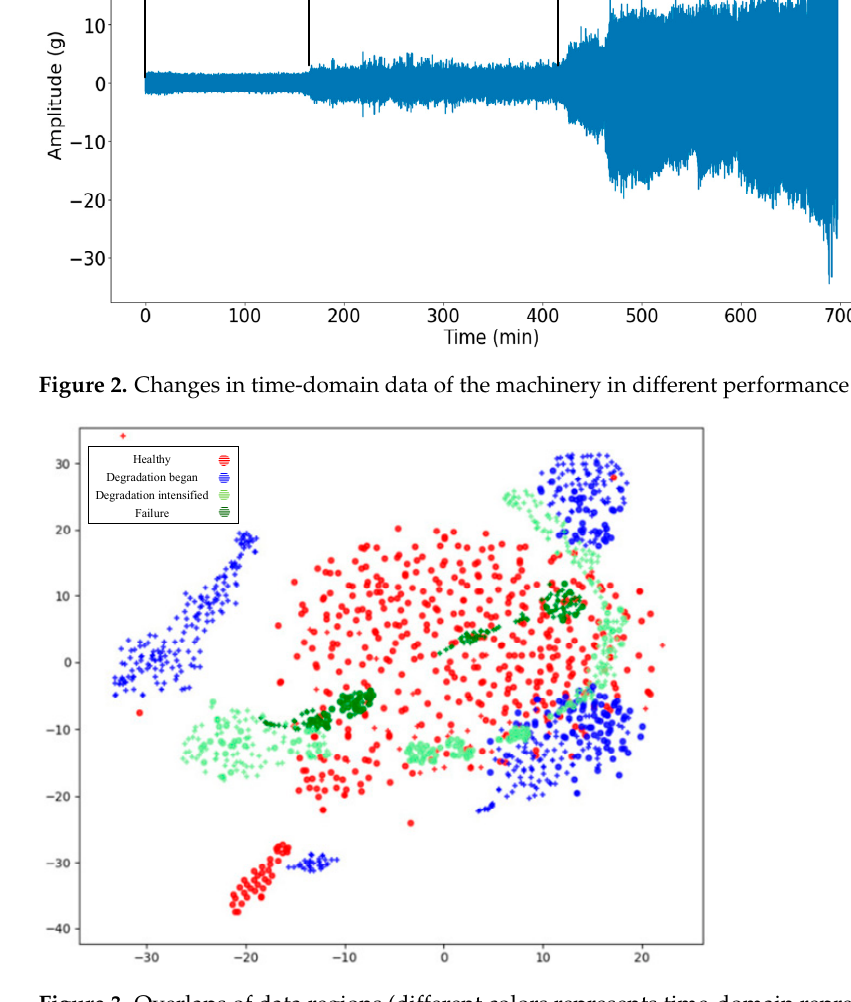
Figure 3. Overlaps of data regions (different colors represents time-domain representation data of different performance states).